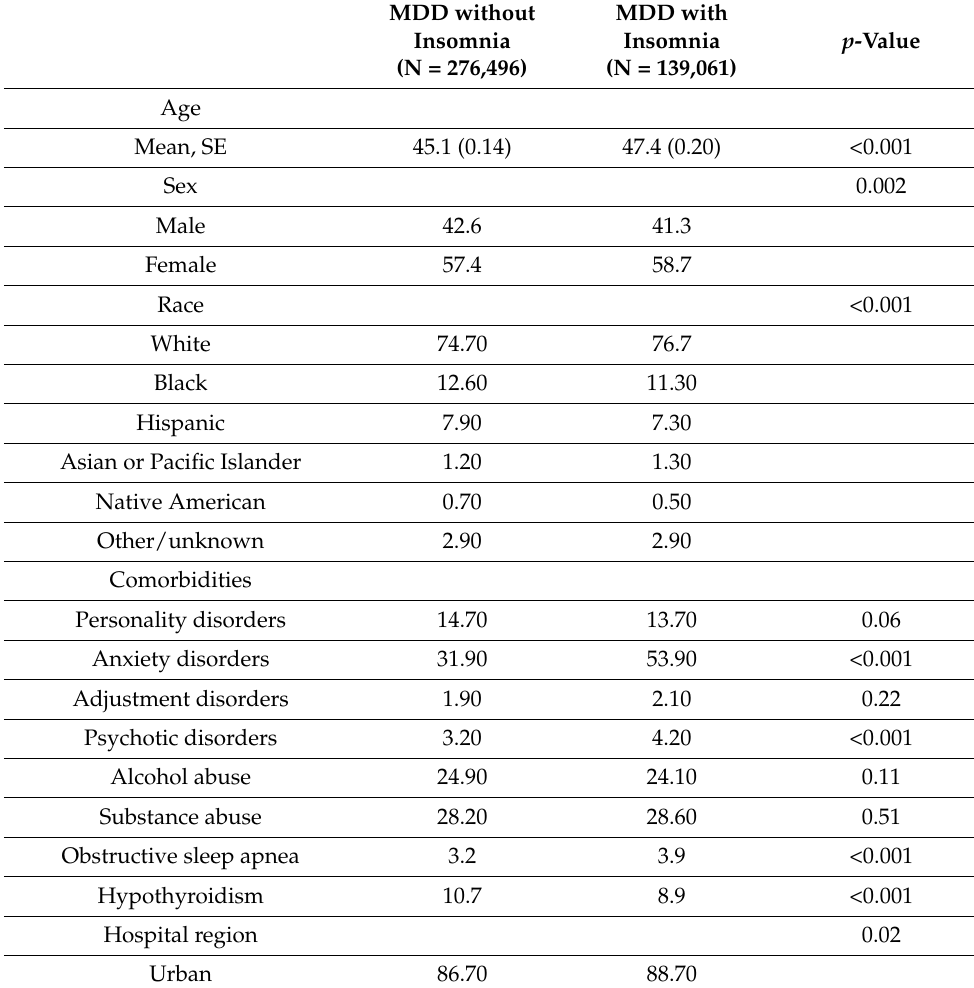
Table 1. Baseline Patient and Hospital Characteristics of study population.